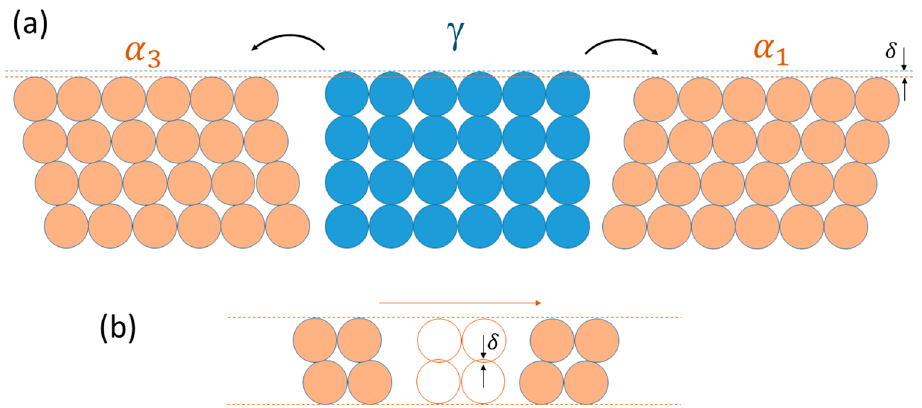
Figure 21. Two-dimensional scheme with a hard-sphere square ( γ )–rhombus ( α ) transformation explaining why the distortion variants cannot be transformed into one another by a simple shear—i.e., by deformation twinning. ( a ) Two distortion variants, α 1 and α 3 , generated from the parent γ lattice. The atoms are represented by disks of same size in blue for γ and orange for α . ( b ) A continuous shear between α 1 and α 3 would imply a large interpenetration of the atoms (with a strain δ ) and an unrealistic energetic gap. A transformation via the parent phase γ seems more realistic.